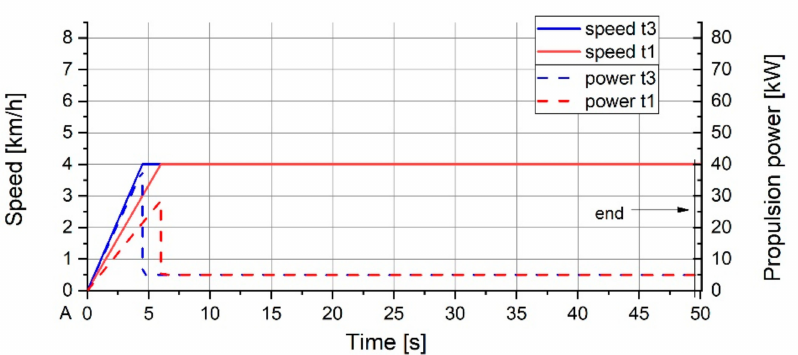
Figure 9. Profile of speed and power demand in the first stage of the cruise using the AG strategy at two di ff erent accelerations, t1 and t3, when the ferry covers 52 m.